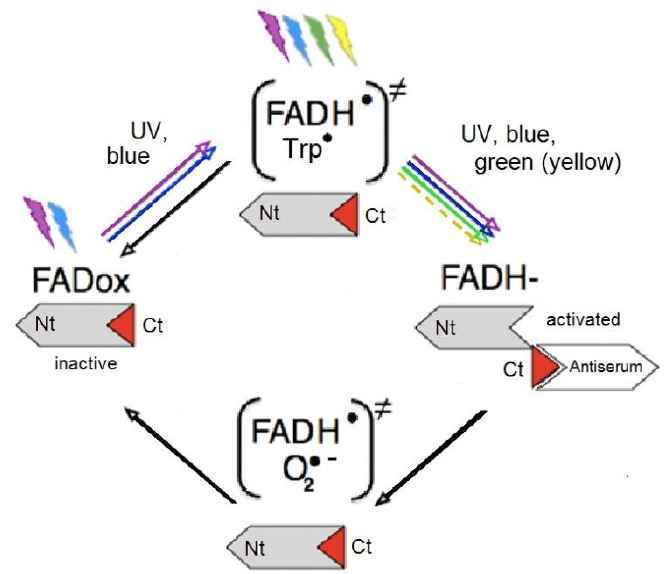
Figure 10. The redox cycle of flavin. FADox, oxidized flavin; FADH ● , photo-reduced neutral radical form; FADH − , fully reduced form. Nt, nitrogen-terminus; Ct, carboxy-terminus of the Cry1a, with the antiserum-binding epitope in red. In parentheses, radical pairs, black arrows indicate light-independent reactions (from [77] after [79],